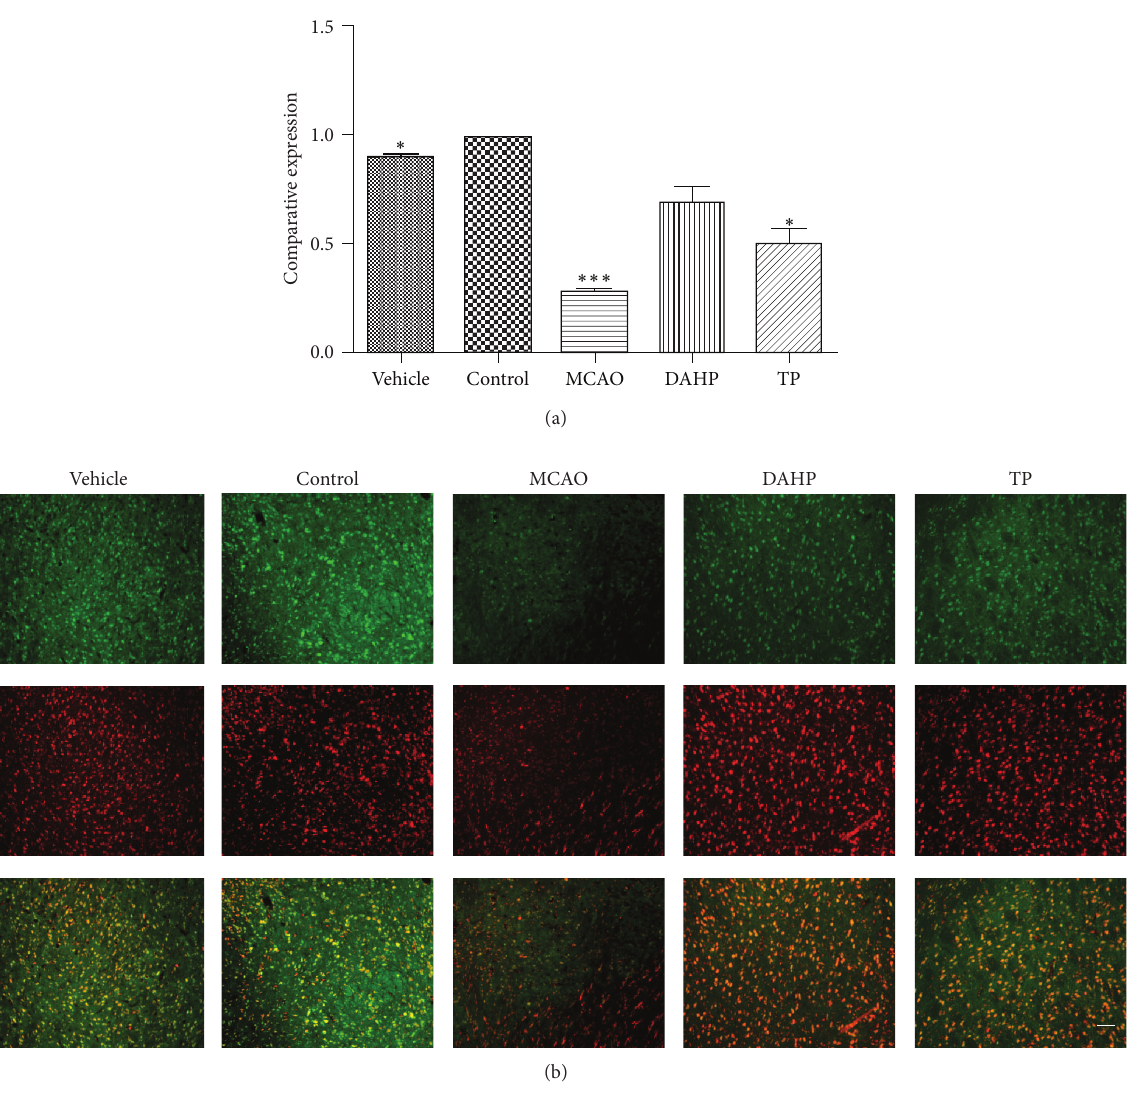
Figure6:ImmunofluorescentanalysisofBcl-2expressionrepresentsantiapoptosislevelchanges.TheexpressionlevelsofBcl-2weremarkedly different in each group. (a) In comparison with control, MCAO has only 30% of its Bcl-2 expression, DAHP has 75%, and TP has 60%. Values were presented with the means ± SEMs. ∗ 𝑃 < 0.05 ; ∗∗ 𝑃 < 0.001 ; ∗∗∗ 𝑃 < 0.0001 ; n.s.: no significance. (b) The immunofluorescent results showed a dramatic decrease in Bcl-2 expression in the MCAO group in comparison with the vehicle and control groups, while the DAHP group and TP group attenuated this change. Bar = 100 𝜇 m.